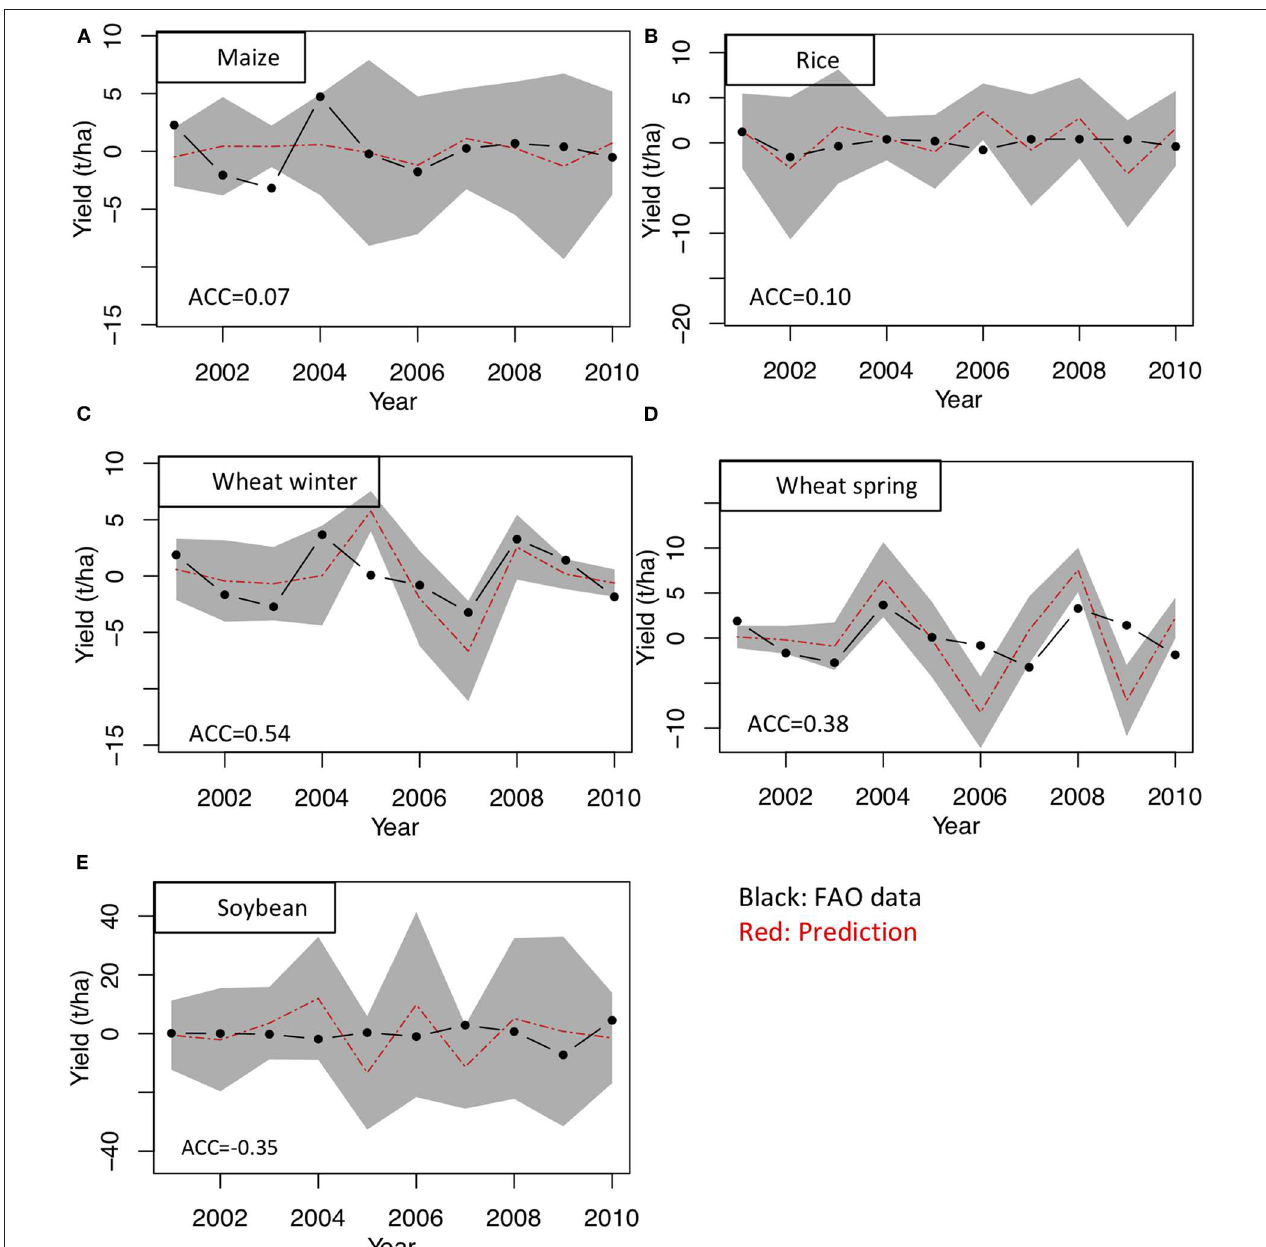
FIGURE 1 | Time series of year-to-year variations of global mean yield of (A) maize, (B) rice, (C) winter wheat, (D) spring wheat, and (E) soybean. FAO data are from the Statistical Division of the UN Food and Agriculture Organization (FAOSTAT). Winter and spring wheat use the same data. The predicted values show a 3-months lead prediction. The shaded areas show the 95% confidence intervals estimated from a six-ensemble spread. The ACC accuracy score is shown at the bottom left corner of each